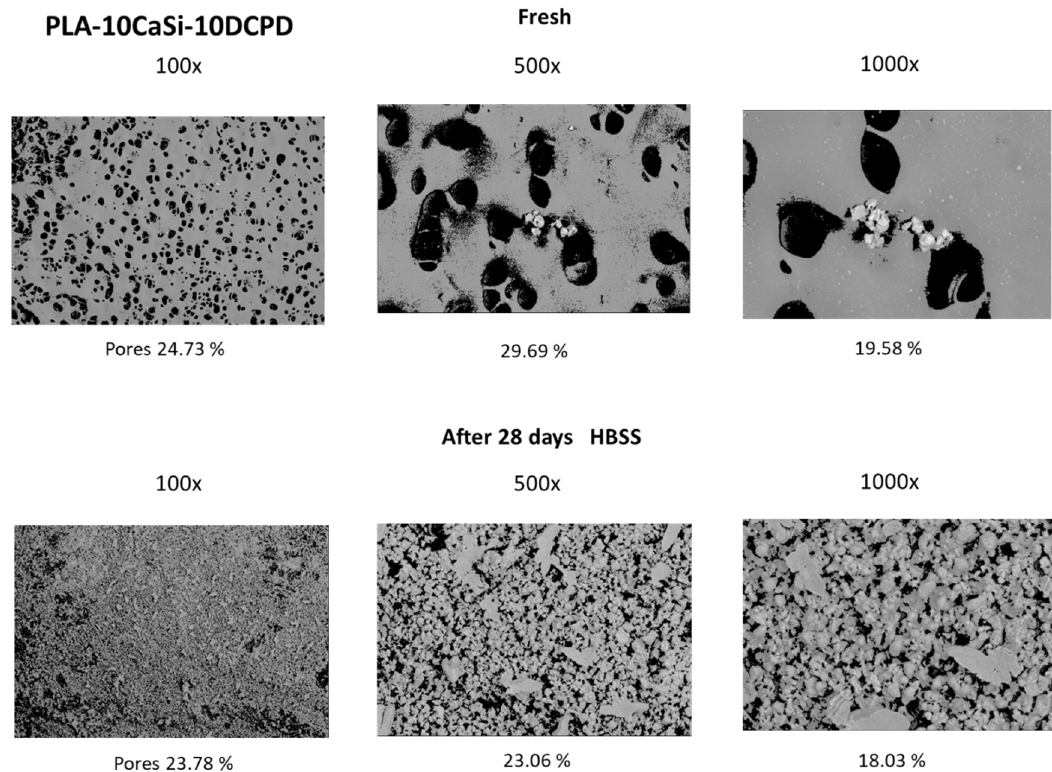
Figure 3. Mineral-doped surface micromorphology by environmental scanning electron microscope (ESEM) of PLA-10CaSi-10DPCD scaffold. Differences in surface porosity were observed when